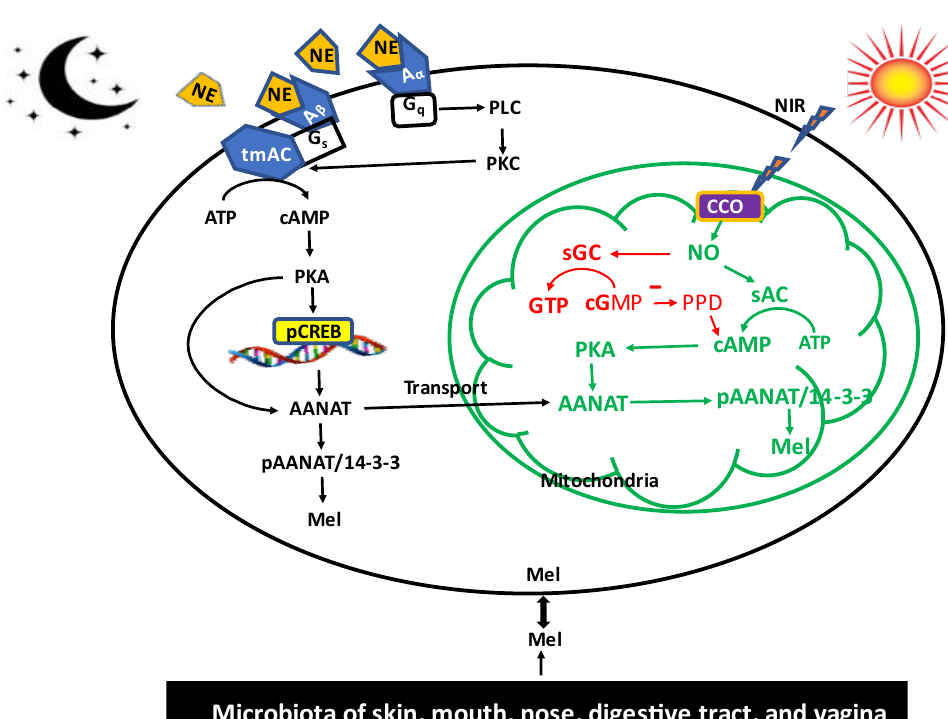
Figure 2. The differentially regulated melatonin synthetic pathway in cytosol, mitochondria, and microbiota. In the pineal, NE, which represents the dark message, acts on the A β and A α membrane receptors to activate the tmAC to generate cytosolic cAMP, which is mitochondria impermeable. NIR is associated with sun exposure and acts mainly on the mitochondrial sAC to increase the mitochondrial cAMP, which in situ phosphorylates the AANTT at the posttranslational level. This model assumed an activation of sAC by NO, which would require further confirmation. In addition, NO activates sGC to increase cGMP, which can inhibit the phosphodiesterase to reduce cAMP degradation and further increases the mitochondria cAMP content. The posttranslational regulation of AANAT activity quickly increases the melatonin synthesis, as seen in extrapineal cells. The regulatory mechanisms of melatonin synthesis in microbiota are currently unknown, but it is hypothesized there is a reciprocal effect between the melatonin produced by the host and microbiota. NE: norepinephrine, A β : β adrenergic receptor, A α : α adrenergic receptor, G s : stimulatory G protein, G q : G protein q subunit, tmAC: transmembrane adenylyl cyclase, sAC: soluble adenylyl cyclase, sGC: soluble Guanyl cyclase, PPD: phosphodiesterase, PLC: phospholipase C, PKC: protein kinase C, PKA: protein